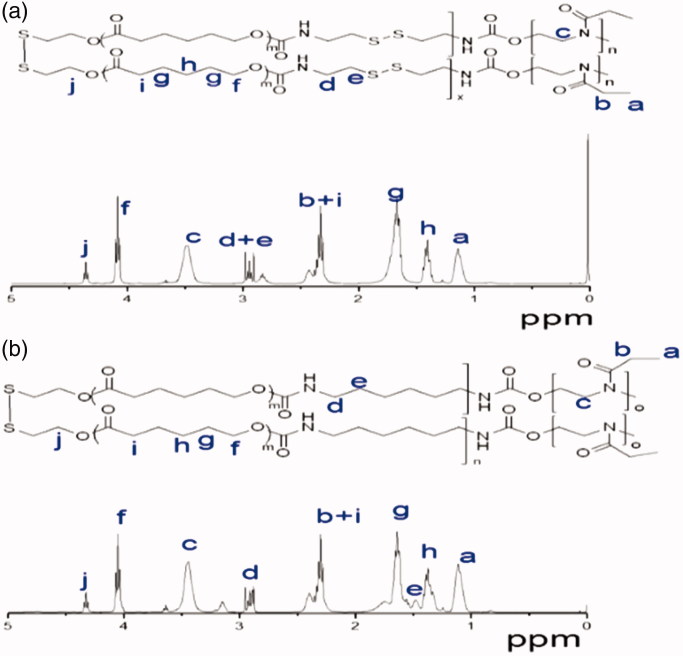
(a) 1H NMR spectrum (400 MHz, CDCl3) of PEtOz-b-PU (SS)-b-PEtOz copolymer. (b) 1H NMR spectrum (400 MHz, CDCl3) of PEtOz-b-PU-b-PEtOz copolymer.